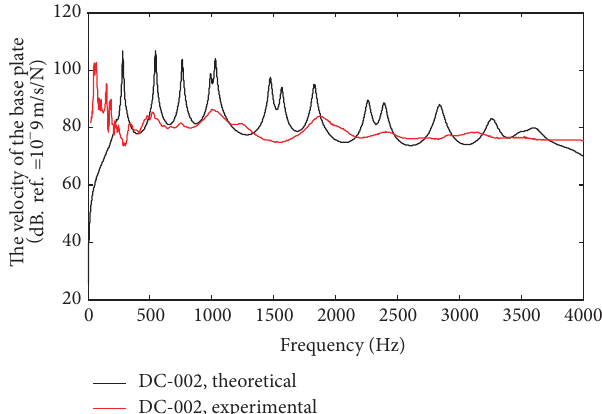
Figure 7: Comparison of theoretical and experimental values of V 2 1